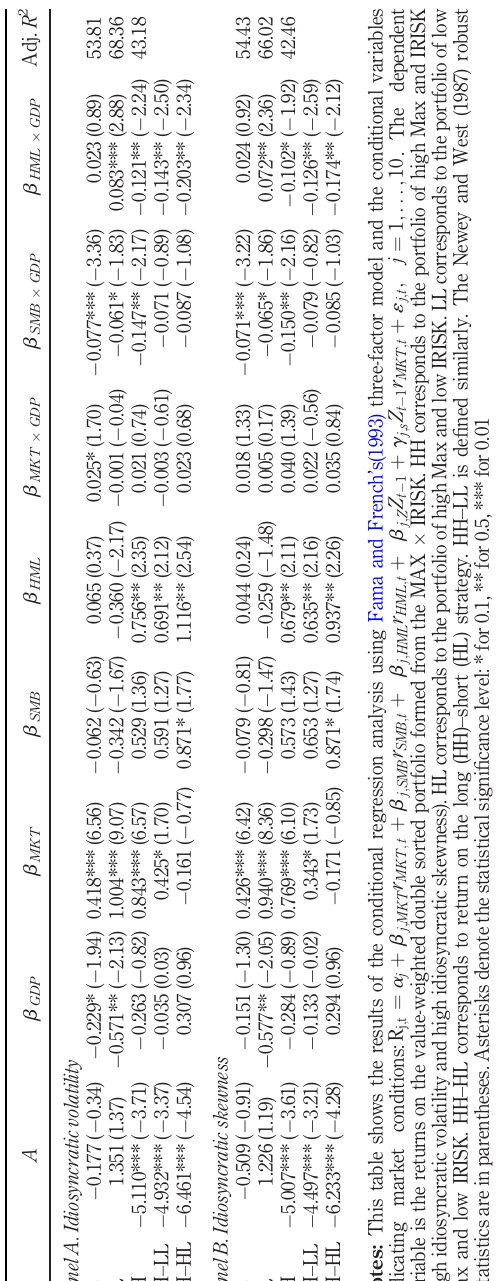
Table 10. Conditional regressions with GDP growth: MAX and